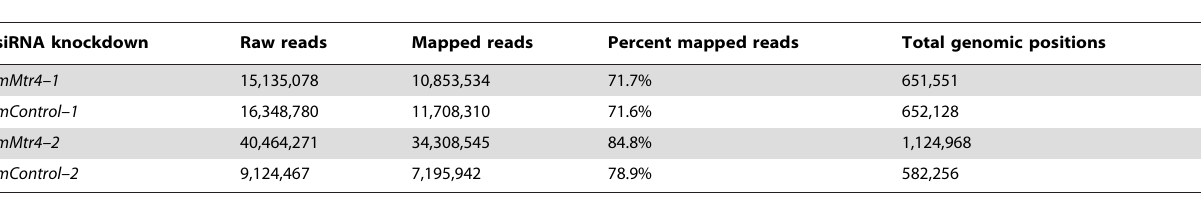
Table 1. Summary of paired-end sequencing experiments.